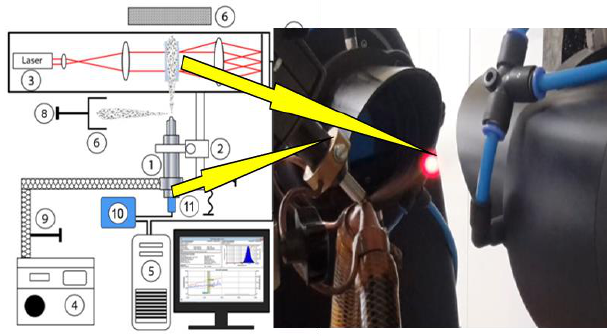
Fig. 5. Scheme of the experimental device for determining the quality of the atomized fuel and acoustic emission: 1 – nozzle, 2 – nozzle attachment